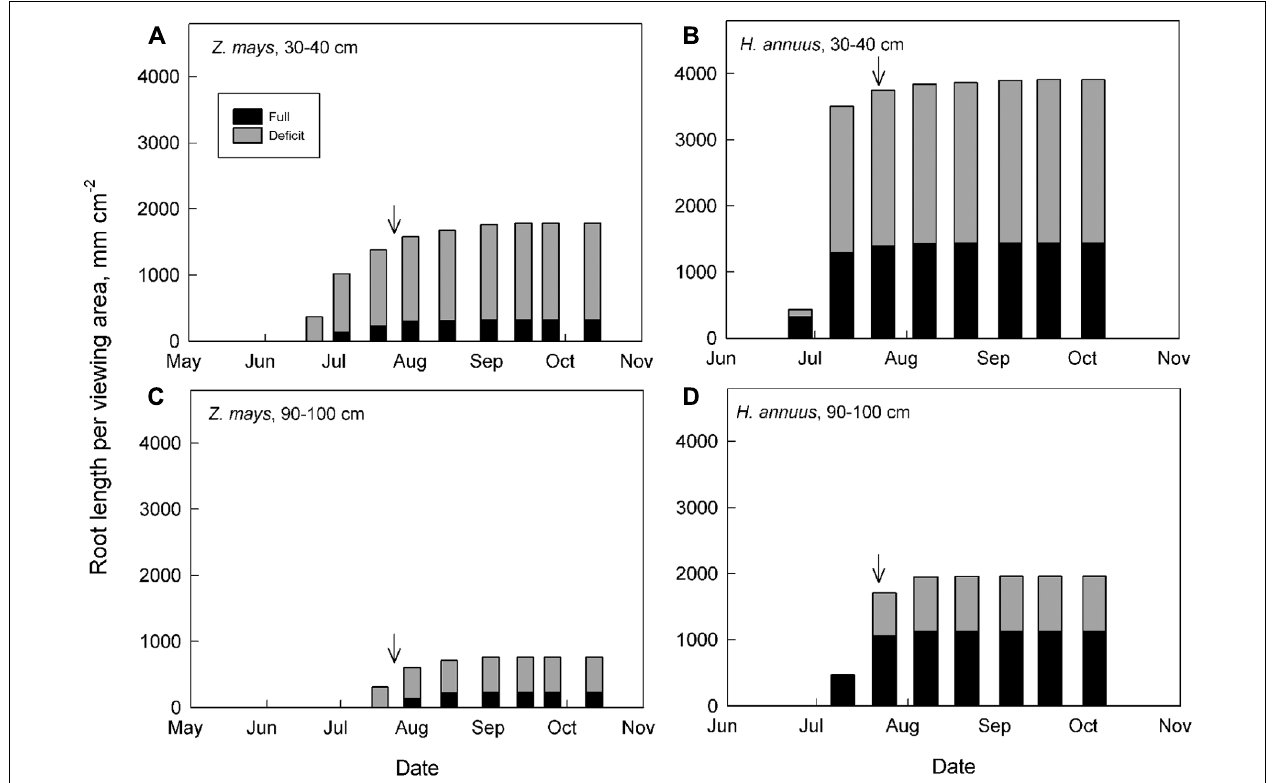
in Figure 2 . Each bar represents root growth averaged among four minirhizot- ron tubes per treatment. Arrows indicate the beginning of the critical repro- ductive phase for each crop (R1 in maize, July 23; R3 in sunflower, July 20).